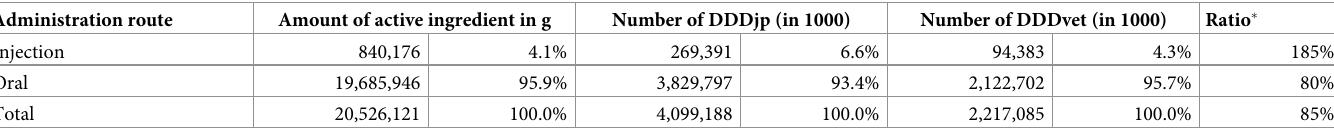
Table 2. Total and relative antimicrobial uses on the 74 Japanese pig farms in the year 2019. Administration route Amount of active ingredient in g